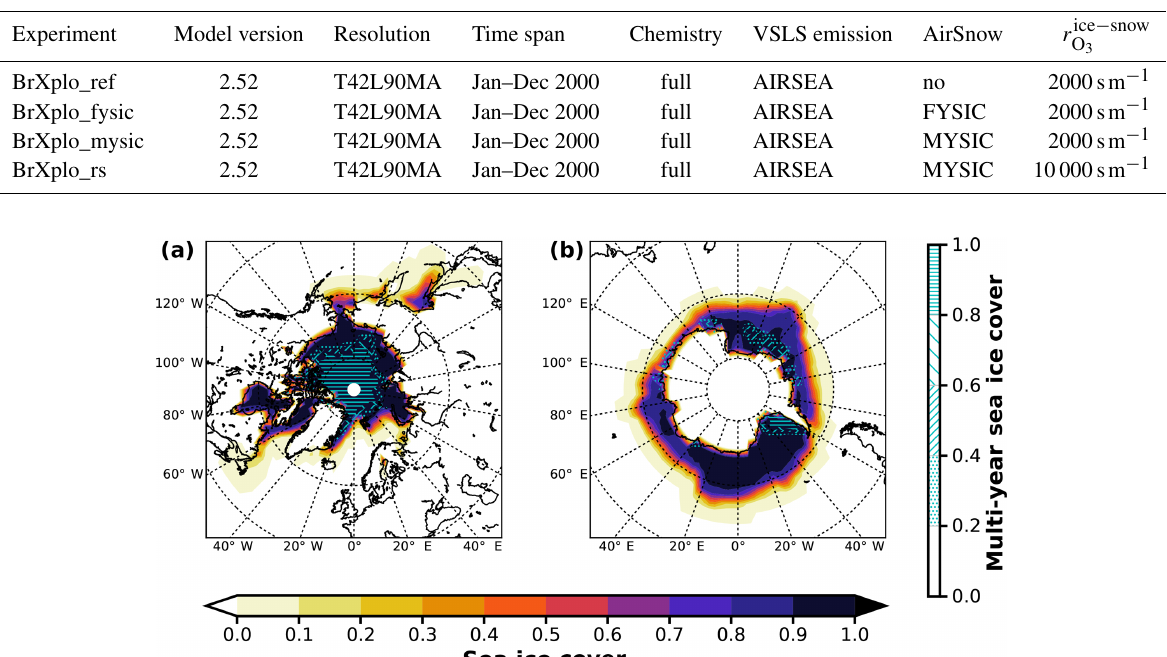
Table 1. EMAC model experiments used in this study. All experiments have been done using specified dynamics nudged to ERA-Interim. Accordingly, ERA-Interim SIC has been used. The setup is based on the consortial ESCiMo simulation RC1SD-base-08. Experiments have been performed for an assumption of first-year sea ice only (FYSIC) and for a multi-year sea ice cover (MYSIC) estimated from SIC. The temperature threshold for all simulations has been T crit = − 15 ◦ C, accordingly.